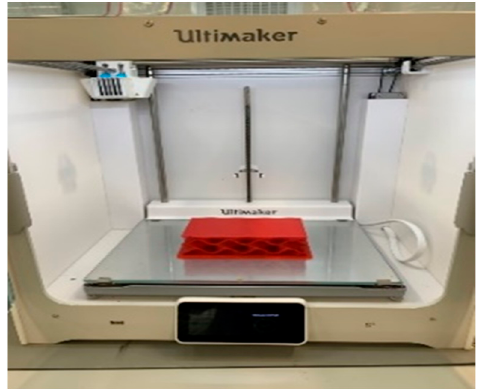
Figure 3. Additive manufacturing for the 3DPPBB specimen using an Ultimaker 3D printer. Table 1. Physical and Mechanical Properties of the Plate and Bearing.